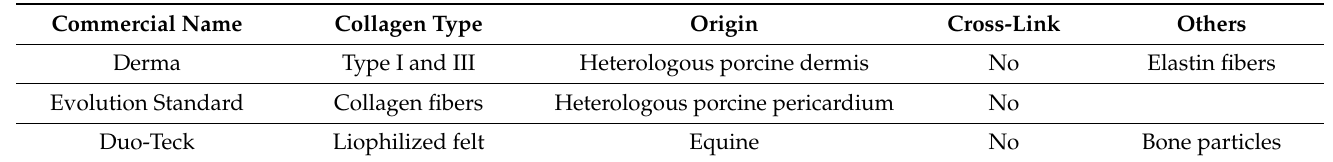
Table 1. Commercial name, collagen type and origin of the membranes. The information was obtained from the membrane